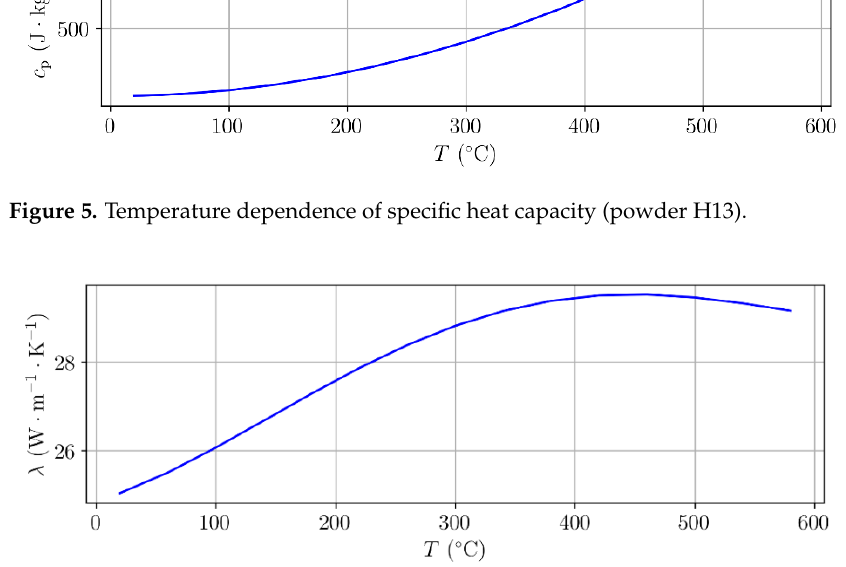
Figure 6. Temperature dependence of thermal conductivity (powder H13).